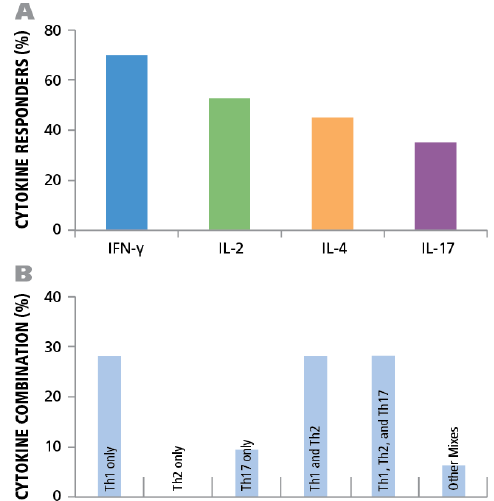
Figure 7. Establishing cytokine signature of CD4 cells. PBMC from 45 healthy donors were